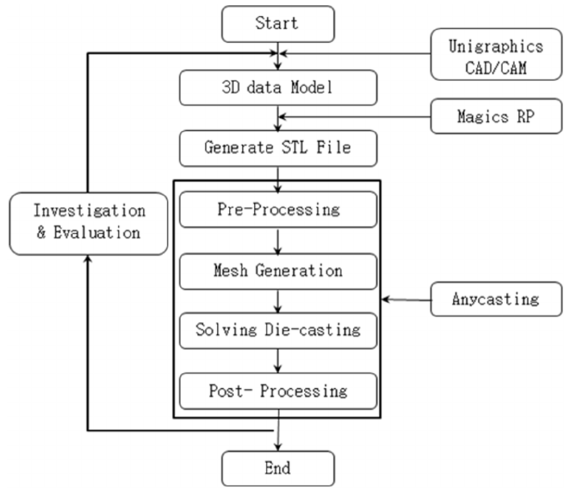
Figure 1. Flow Chart of CAE simulation.